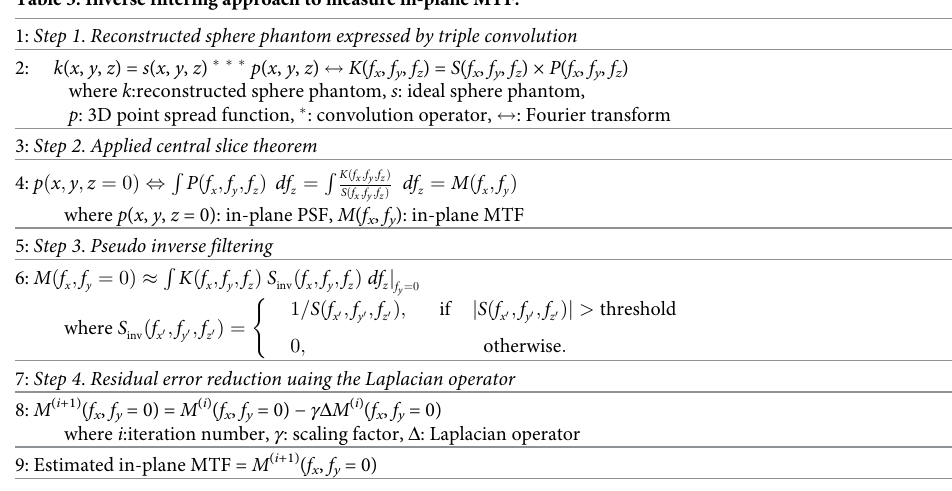
Table 3. Inverse filtering approach to measure in-plane